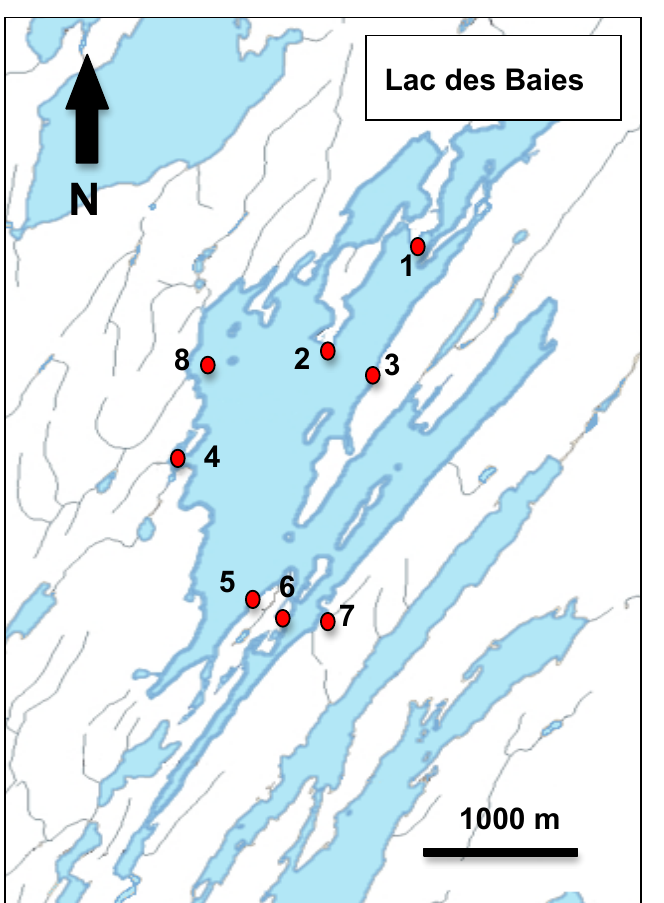
Figure 1. Sites sampled in August 2007 and July 2008 in Lac des Baies, Québec, Canada.